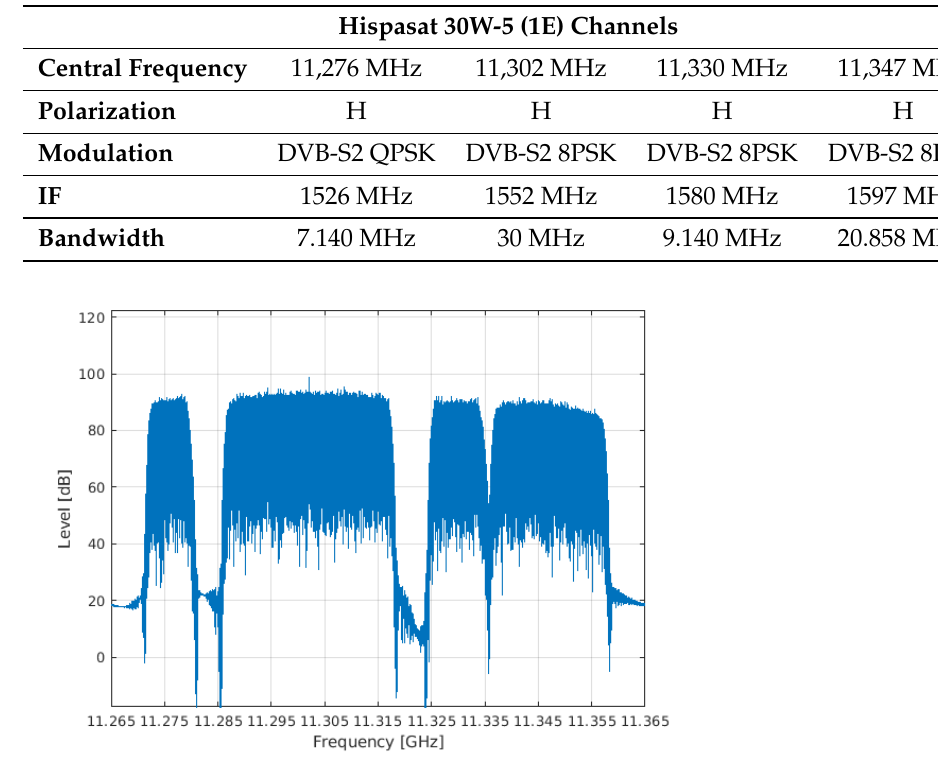
Figure 12. Spectrum of acquired data showing the available DVB-S